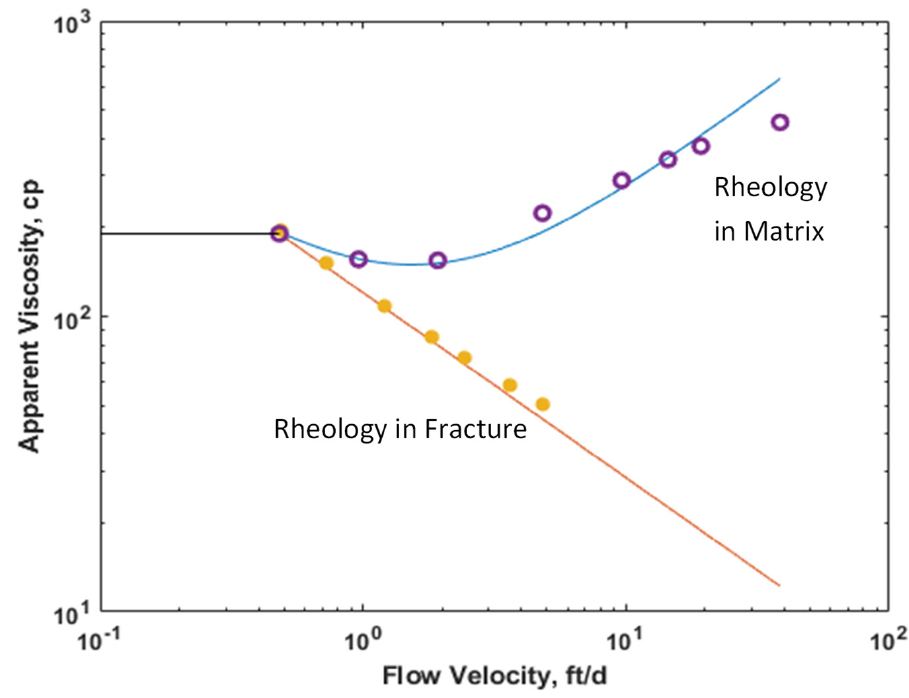
Figure 4. Rheology difference during gelant placement in the matrix and fracture.